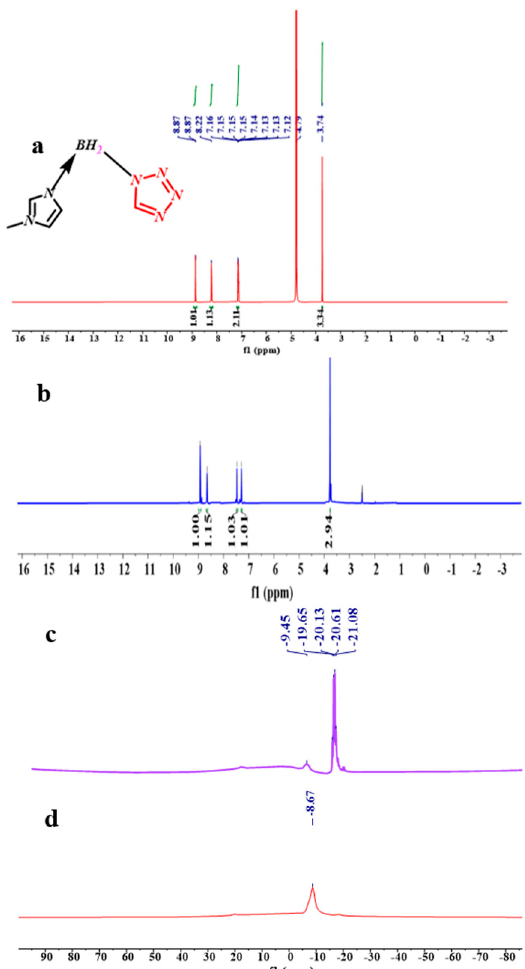
Figure 5. 1 H NMR spectrum of the (1-methylimidazolium)(tetrazol-1-yl)borane (D 2 O) ( a ); 1 H NMR spectrum of the (1-methylimidazolium)(tetrazol-1-yl)borane (DMSO-d 6 ) ( b ); 11 B NMR spectrum of 10 wt% tetrazole into 1-methylimidazole borane complex ( c ); 11 B NMR spectrum of equimolar 1-methylimidazole borane complex and tetrazole ( d ).